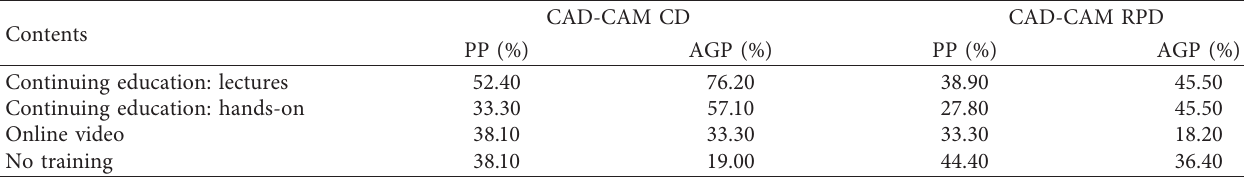
Table 4: The training faculty have had prior to teaching (checked all that